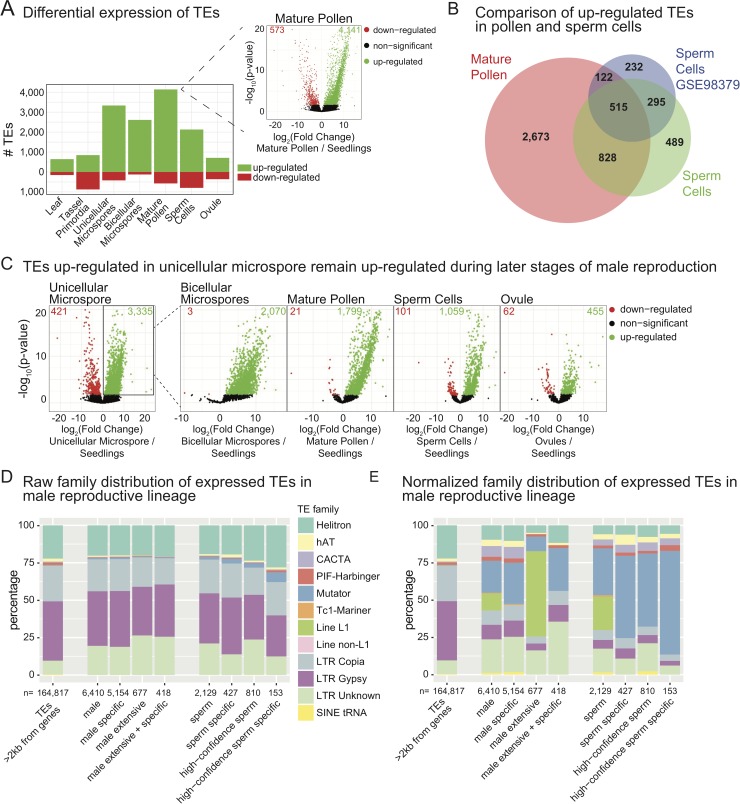
High TE expression in the maize male gametophyte lineage.(A) Number of differentially expressed TEs in seven tissues compared to seedlings. The inset volcano plot shows for mature pollen how differentially expressed TEs were identified. Green and red numbers within the volcano plot indicate how many TEs were statistically up- or down-regulated, respectively. (B) Number of up-regulated TEs in mature pollen compared to isolated sperm cells from this study and a previously published distinct isolation and sequencing of sperm cell mRNA. (C) Starting with TEs differentially up-regulated in unicellular microspores (boxed, far left volcano plot), we determined how many of these same TEs are expressed at other developmental time points. (D) Raw distribution of expressed TE family annotations. ‘Male’ refers to the set of TEs expressed in any male lineage dataset (MS, MS-B, MP, SC). ‘Male specific’ are TEs expressed in only the male lineage (not other tissues / timepoints). ‘Male extensive’ TEs are expressed in all of the male lineage datasets, and ‘male extensive + specific’ refers to TEs expressed all male lineage datasets and not other tissues / timepoints. ‘High-confidence sperm’ refers to TEs identified as expressed in both analyzed sperm cell datasets from part B. (E) Expressed TE family annotations normalized to the genome-wide TE distribution of TEs >2 kb from genes. Categories are the same as part D.